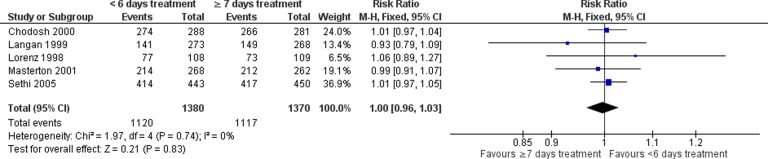
Forest plot of early clinical success, within 6 days of treatment completion, <6 versus ≥7 days antibiotic duration.